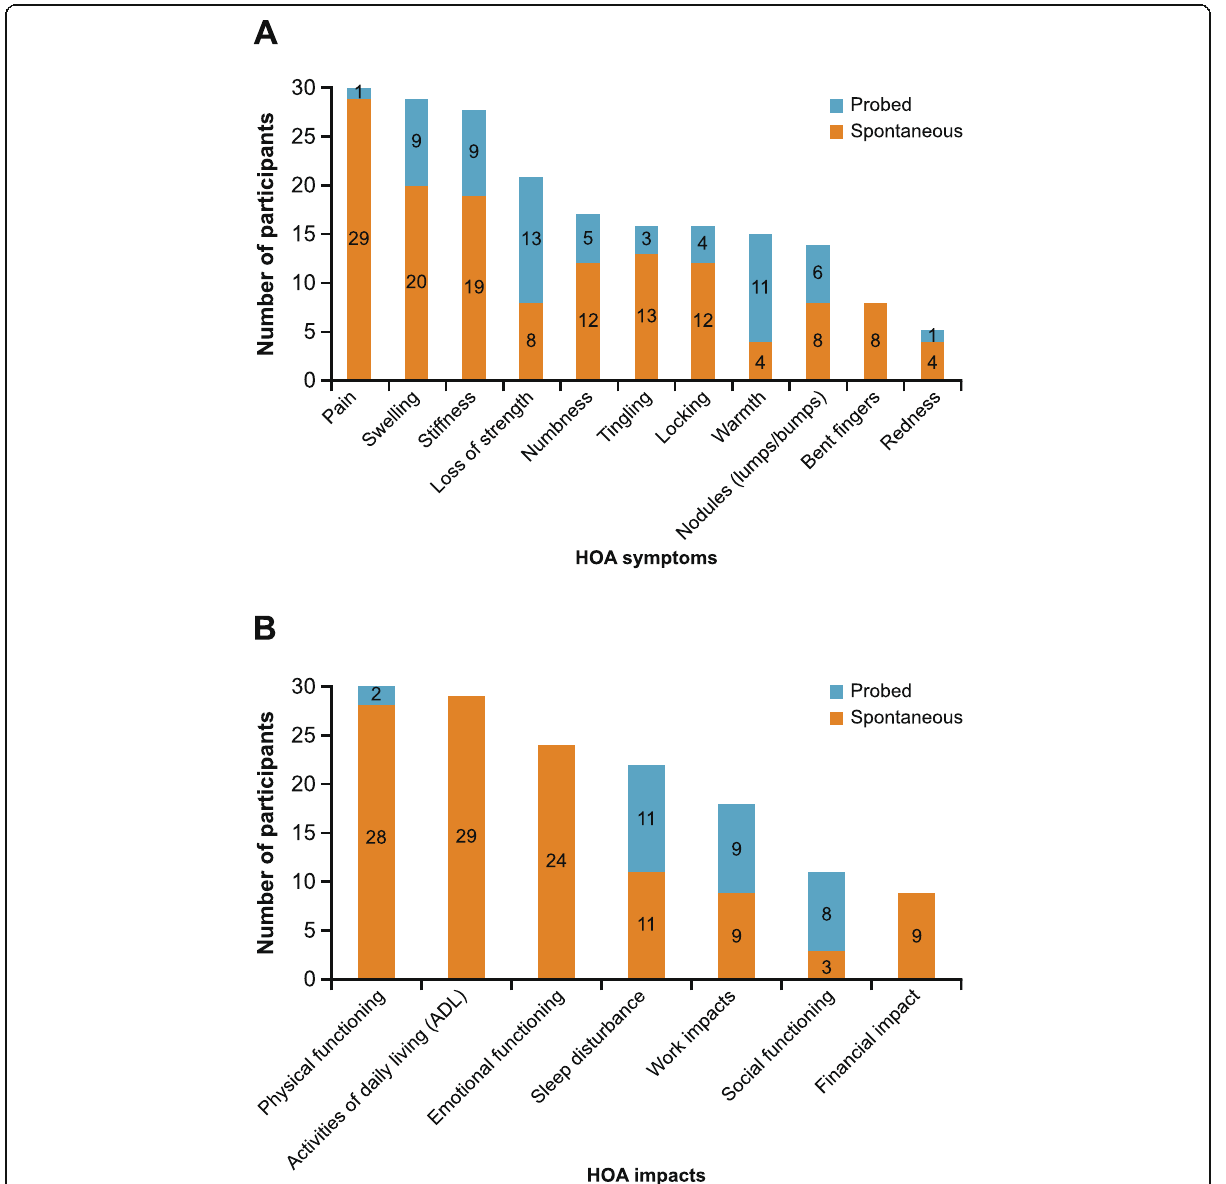
Fig. 2 Overview of a HOA symptoms and b HOA impacts reported in concept elicitation interviews. HOA: Hand